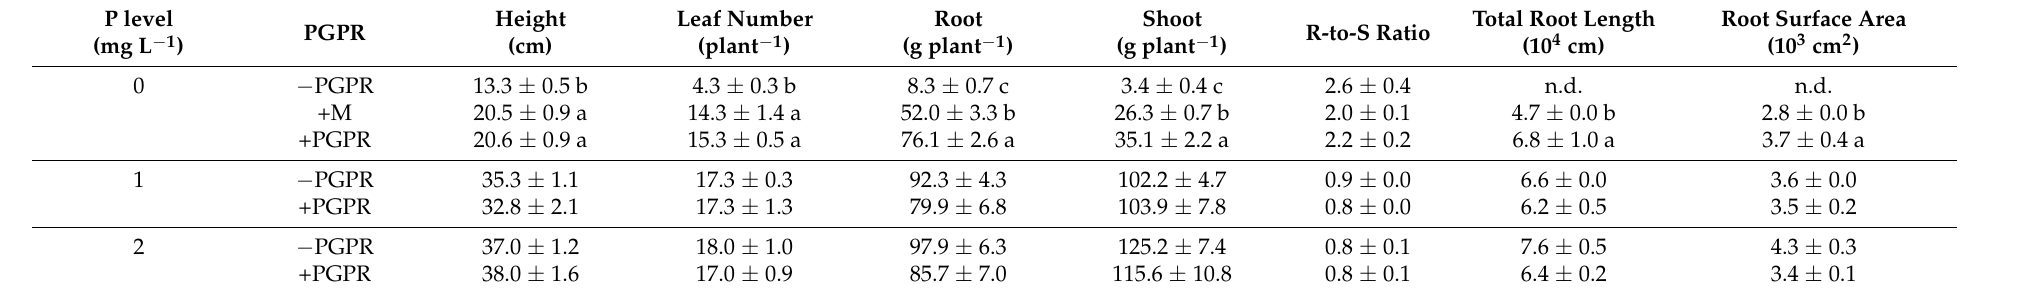
Table 1. Effect of PGPR on shoot and root growth at low P applications.